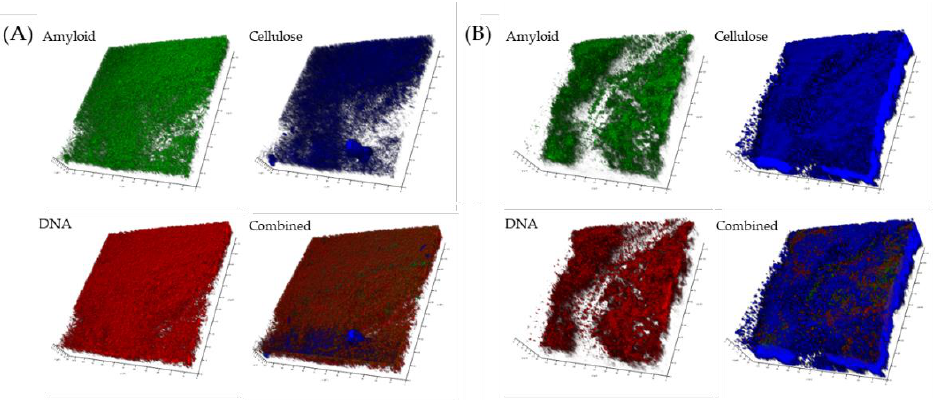
Figure 5. P. fluorescens biofilms include amyloid fibers. Confocal laser scanning microscopy (CLSM) was used to visualize amyloid fibers in three-day-old Viscous Mass and Wrinkly Spreader and biofilms. Shown here are single-channel and combined CLSM images of Viscous Mass ( A ) and Wrinkly Spreader ( B ) three-day-old biofilms. AmyGreen (green channel) was used to visualize amyloid fibers, Calcofluor white (blue channel) to visualize cellulose, and ethidium bromide (red channel) to visualize total DNA as a proxy for live cells, respectively, and all three channels are combined in the bottom-right images. Note the low signal region running down the Wrinkly Spreader image. The dimensions of the images are 115 × 115 × 20/35 µm.